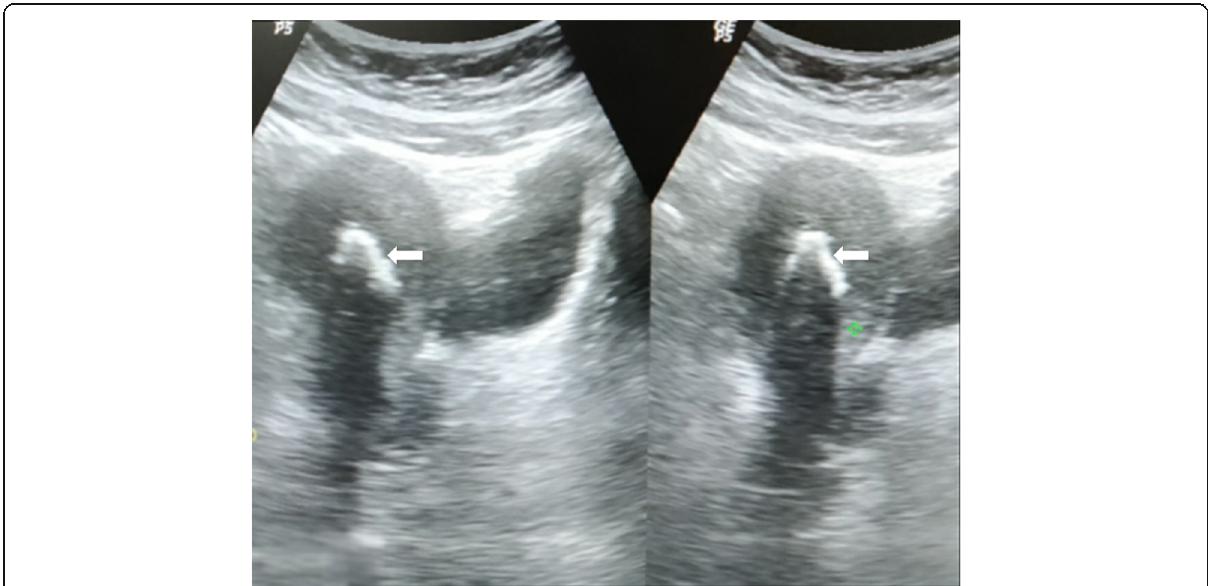
Fig. 3 Sagittal split-screen transabdominal ultrasound images in a 28-year-old infertile patient revealing curvilinear echogenic area in endometrial canal with dense posterior acoustic shadowing (arrows). Subsequent HPE revealed calcific